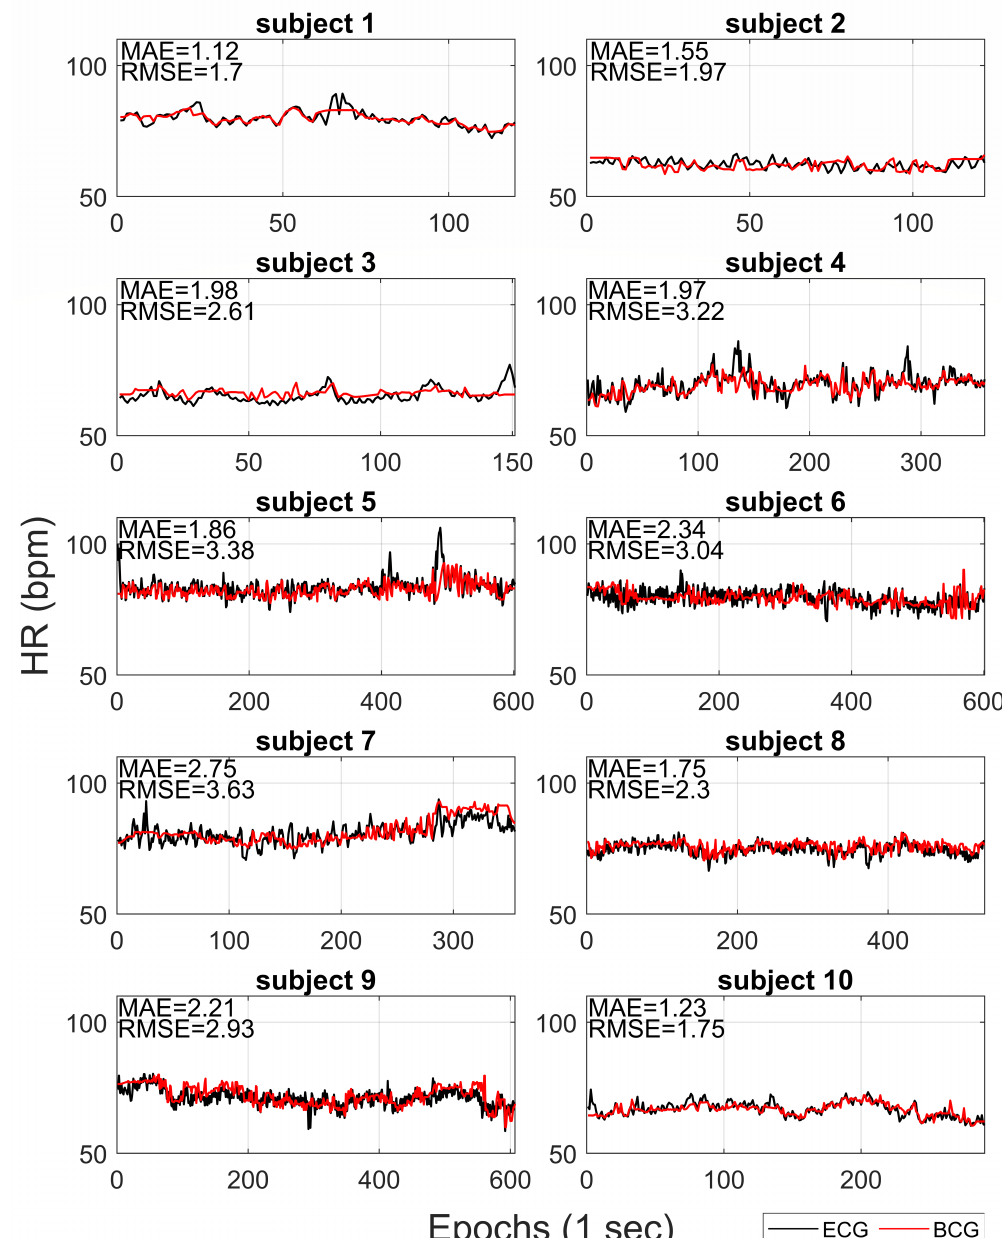
Figure 3. For each subject, the HR extracted from BCG (red lines) and HR from ECG (black lines) are reported. The correspondent mean absolute errors (MAE) and root mean squared errors (RMSE) are